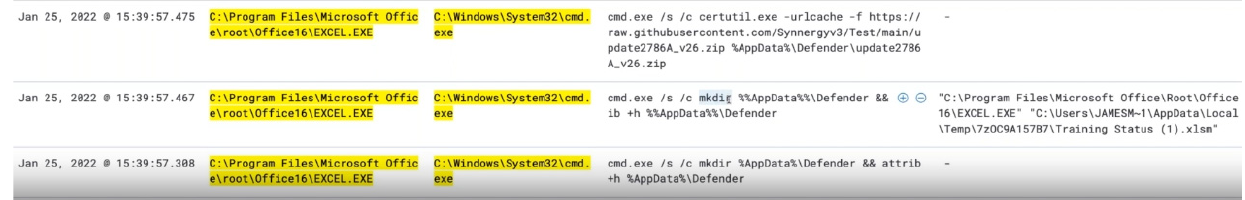
Figure 8. Filtering for process variables.